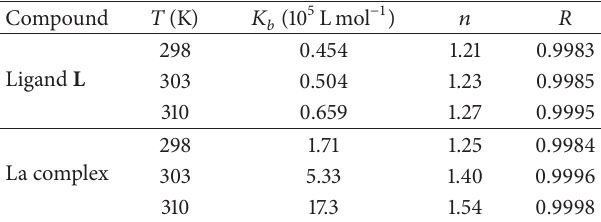
Table 3: The binding constants and binding sites at various temper- atures.